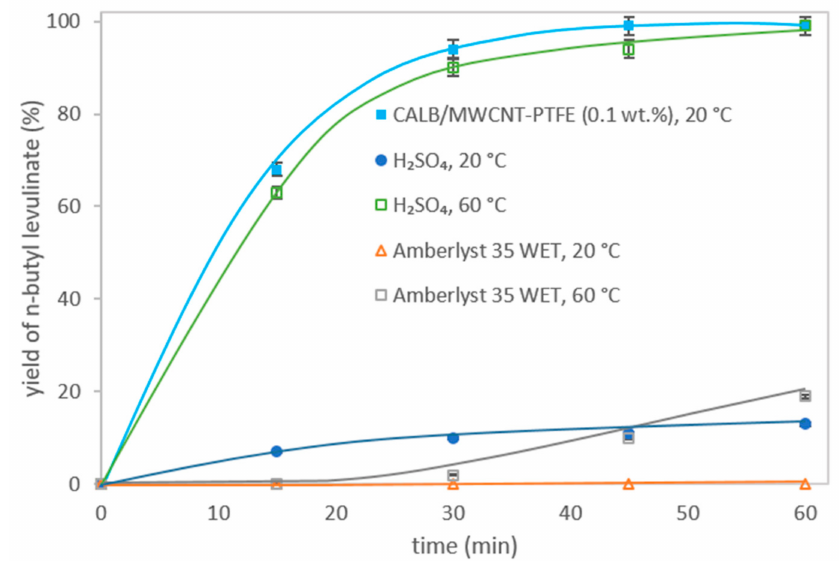
Figure 7. Comparison of various catalysts in LA esterification. Reaction conditions: LA (0.117 g, 1 mmol); n -butanol (0.148 g, 2 mmol); catalyst: biocatalyst CALB/MWCNT-PTFE (0.10 wt.%) (150 mg), CALB (50 mg), H 2 SO 4 (7 mg), Amberlyst 35 WET (150 mg); cyclohexane (1 mL); 250